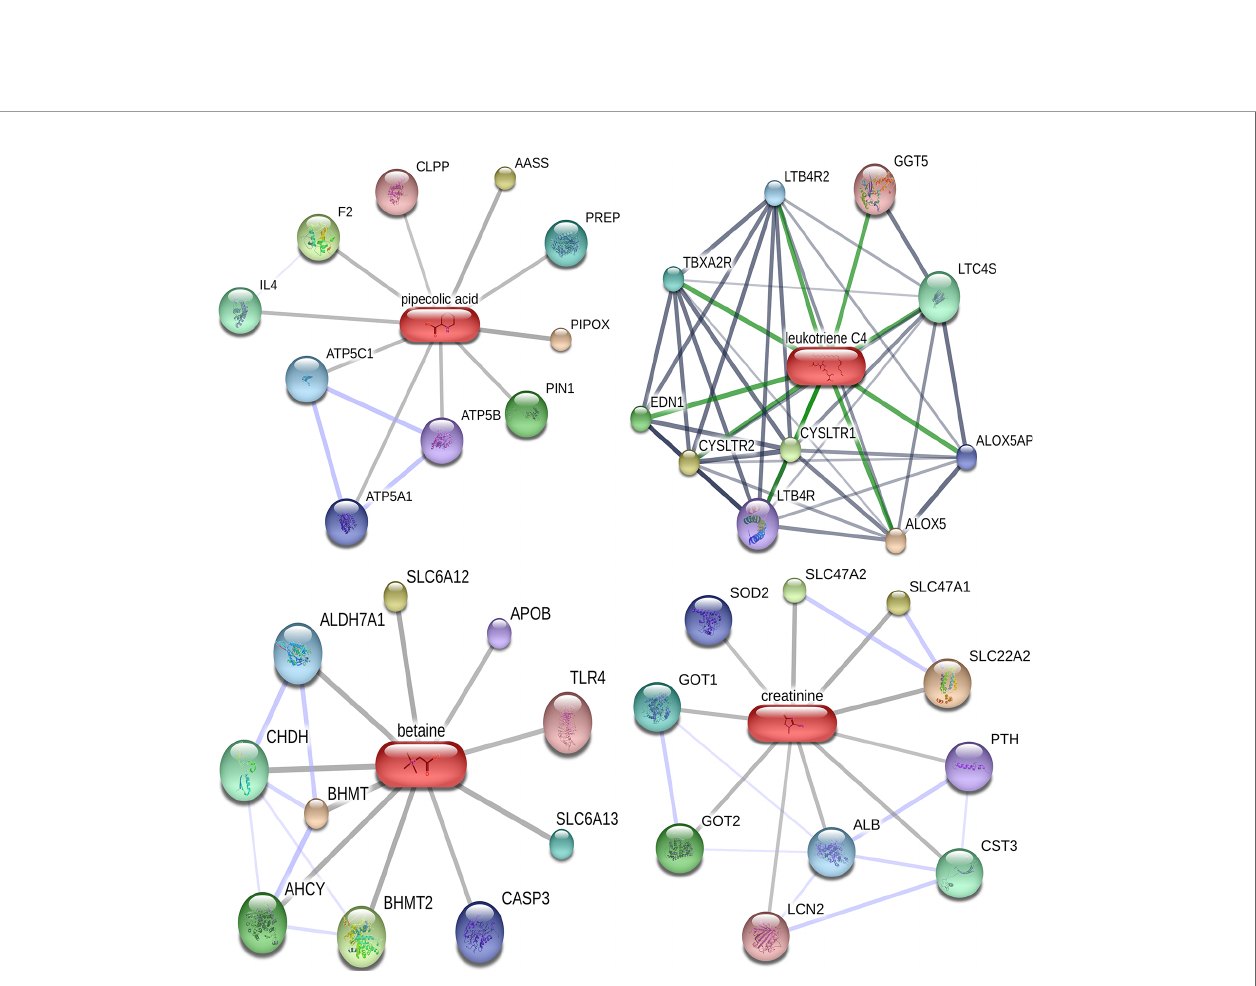
Frontiers in Oncology |